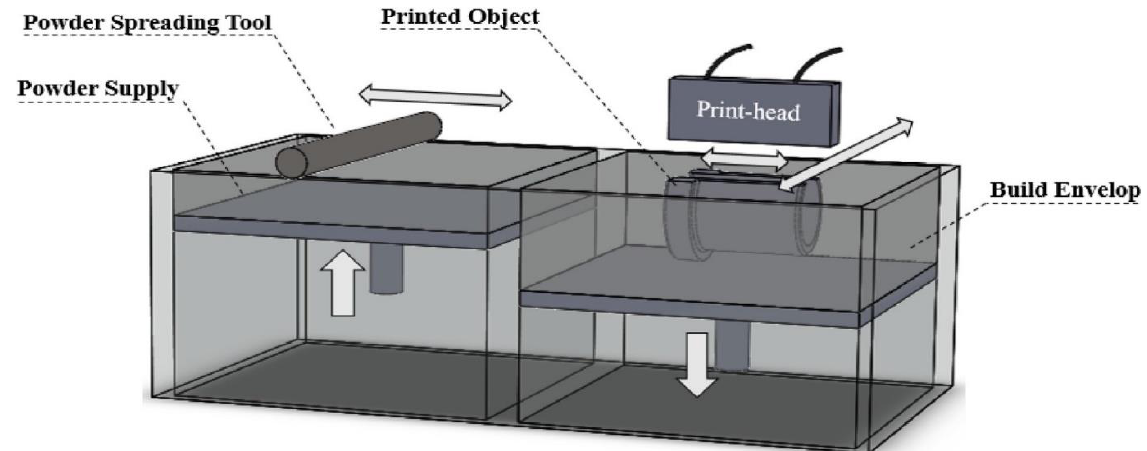
Figure 3. Schematic of Binder Jetting process [21]; with permission from Elsevier.